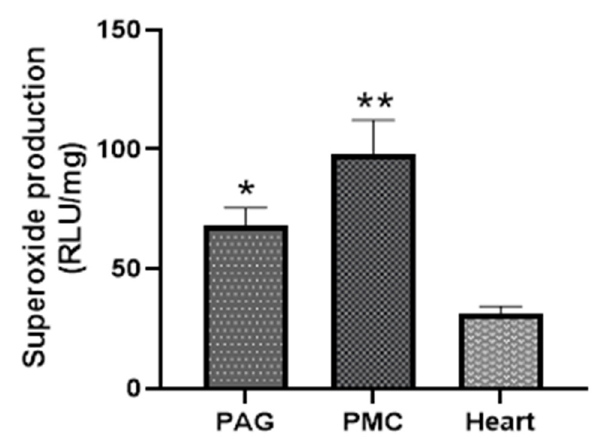
Figure 6. Comparison of superoxide production from PAG and PMC with that in myocardium. * p < 0.05, ** p < 0.01 vs. heart, n = 11.